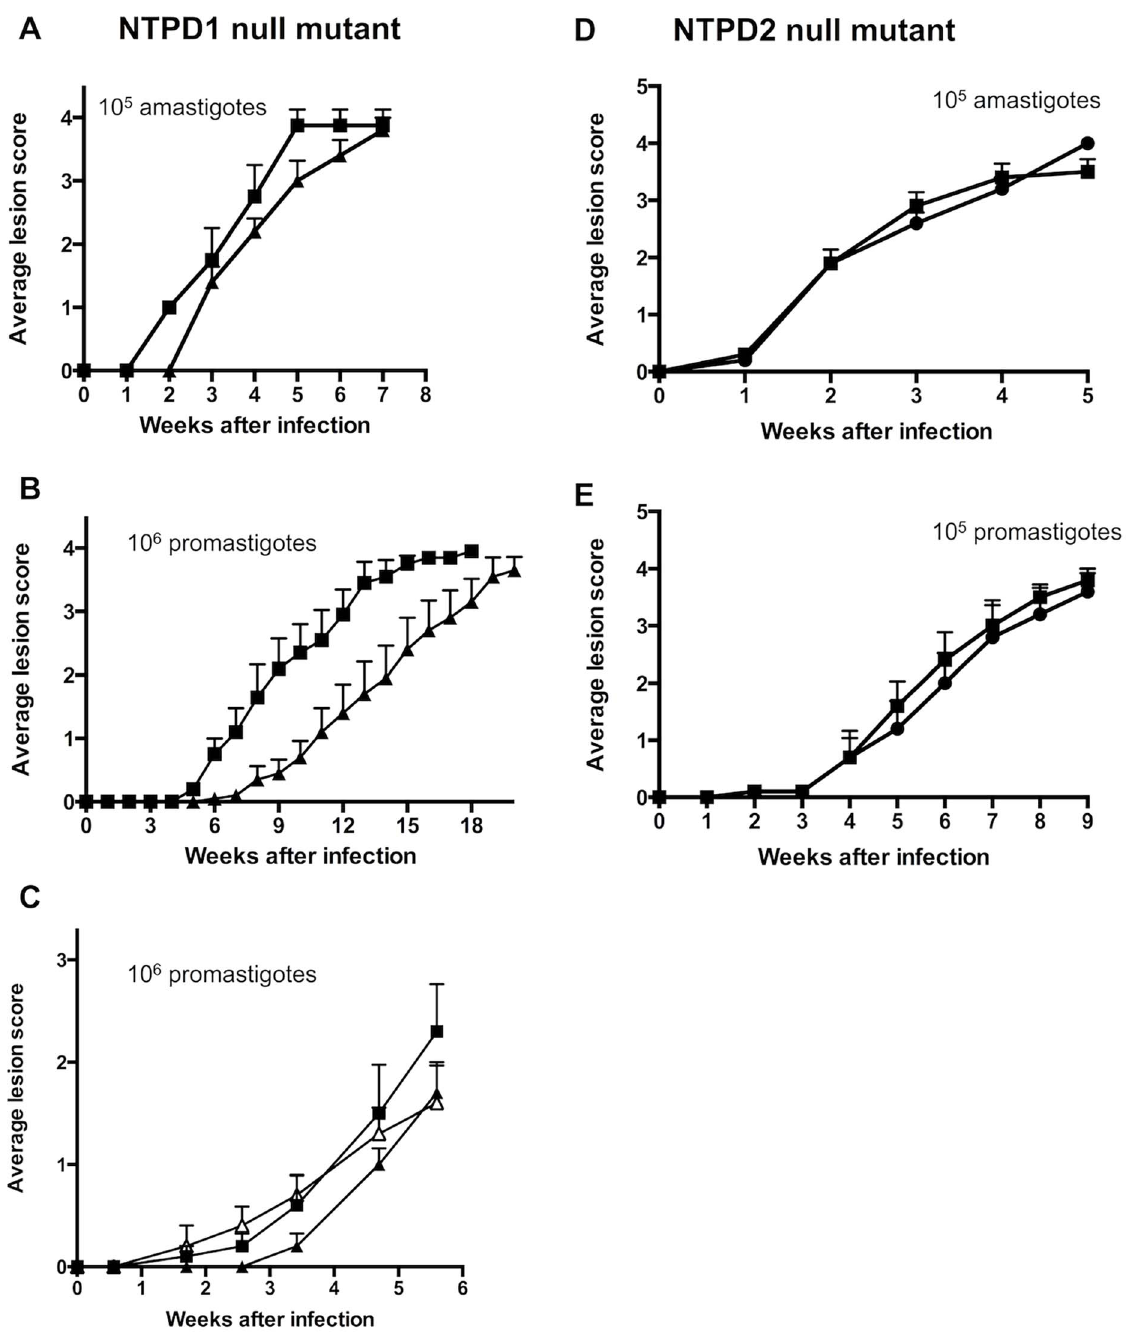
Fig. 3. Subcutaneous infection of BALB/c mice with either amastigote (A, D) or promastigote (B, C, E) L.major . A. Mice were infected with either 10 5 wild type L. major (squares) or 10 5 L. major NTPD1 null mutant (triangles) amastigotes and lesion scores monitored weekly. Error bars represent S.E.M. ( n =5). No significant difference in lesion size was observed at any time point ( P . 0.05, unpaired t-test). B. Mice were infected with either 10 6 wild type L. major (squares) or 10 6 L. major NTPD1 null mutant (triangles) parasites and lesion scores monitored weekly. Error bars represent S.E.M. ( n =10). Significant differences in lesion size were observed at all time points from week 6 inclusive ( P , 0.05, unpaired t-test). C. Mice were infected with either 10 6 wild type L. major + pIR1SAT (squares), 10 6 L. major NTPD1 null mutant + pIR1SAT (closed triangles) or 10 6 L. major NTPD1 null mutant + pIR1SAT- ntpd1 (open triangles). Error bars represent S.E.M. ( n =5). D and E. Mice were infected with either 10 5 wild type L. major (squares) or 10 5 L. major NTPD2 null mutant (circles) parasites and lesion scores monitored weekly. Error bars represent S.E.M. ( n =5). No significant difference in lesion size was observed between strains at any individual time point ( P . 0.05, two-way ANOVA).